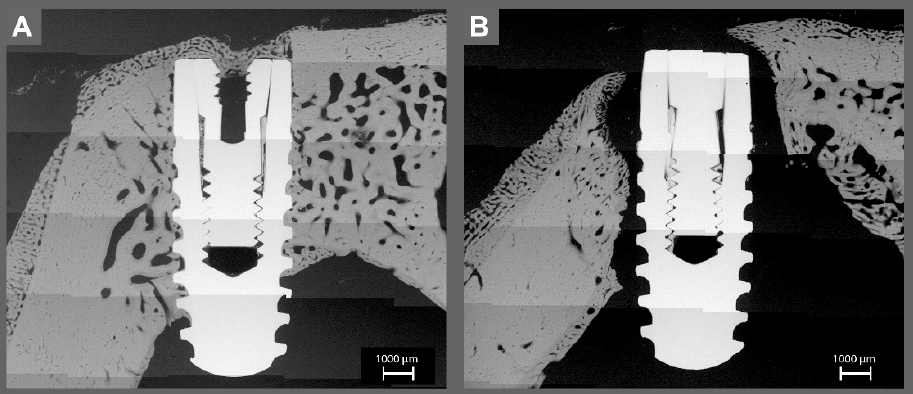
Figure 5. The micro-radiographic examination of the corresponding ( A ) sterile and ( B ) contami- nated implants placed into the frontal bone. Please note the lack of osseointegration around the contaminated implant.